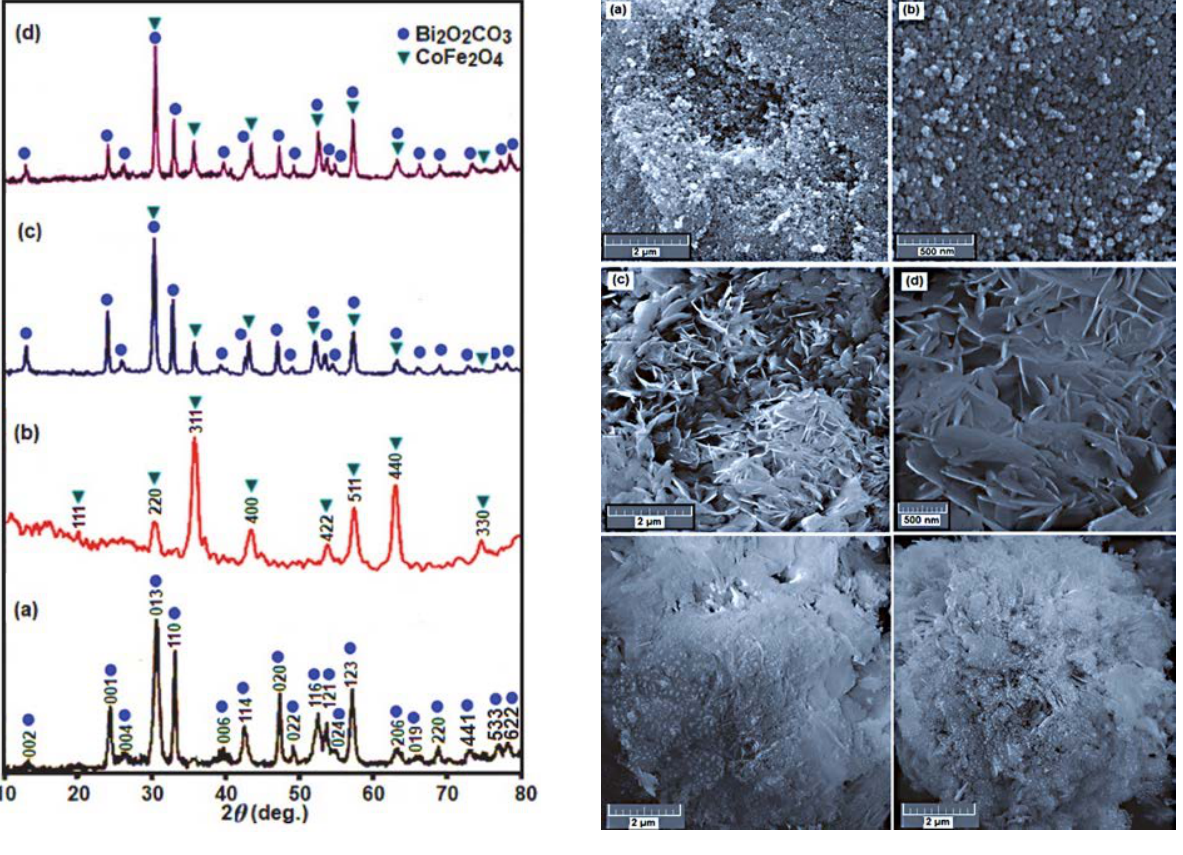
Figure 2. XRD patterns of (a) Bi 2 O 2 CO 3 , (b) CoFe 2 O 4 , (c) Bi